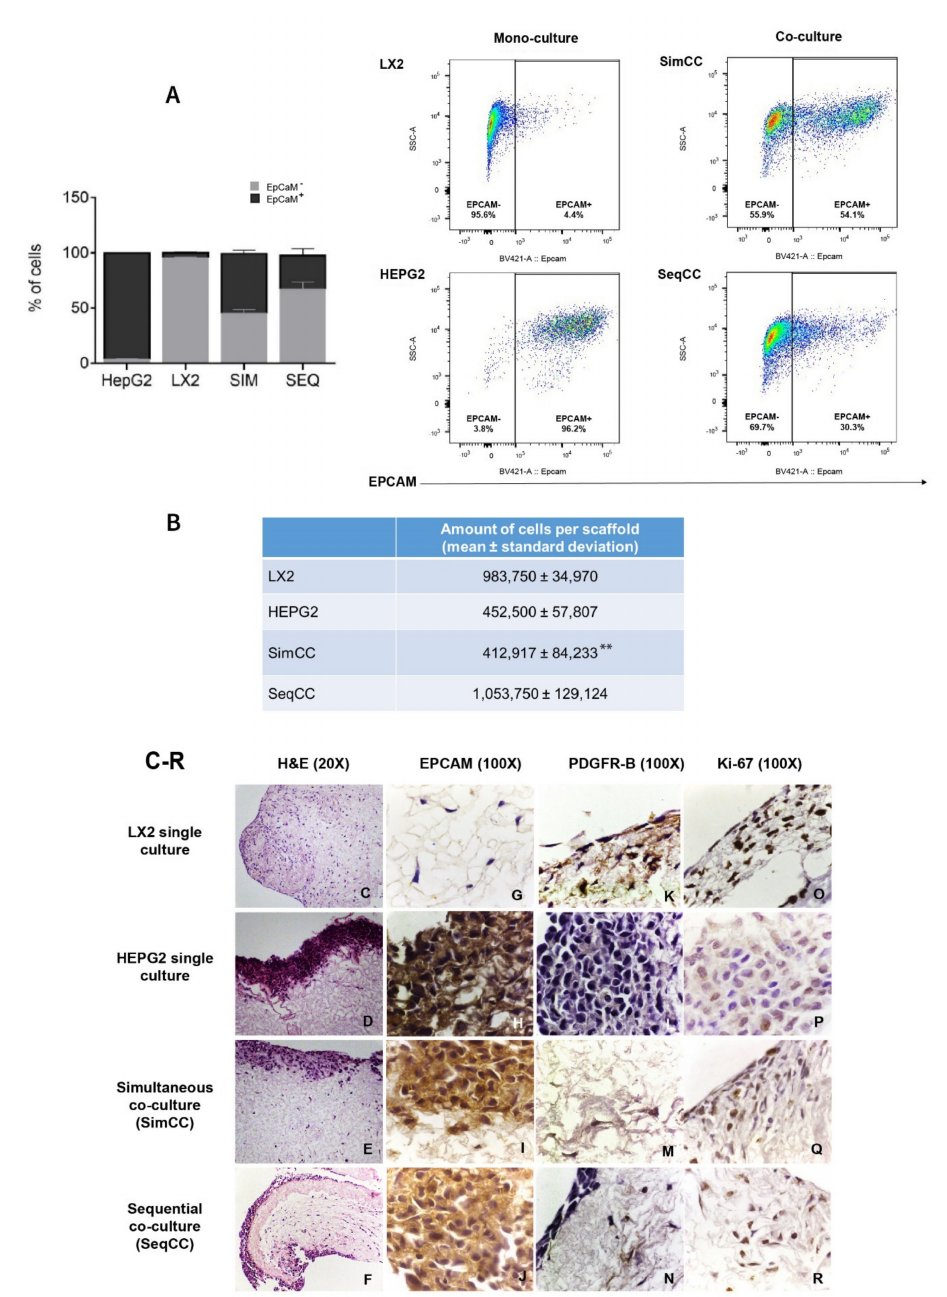
Figure 1. Localization and fluorescence-activated cell sorting (FACS) analysis of LX2 and HepG2 cells in single and co- cultures in 3D liver scaffolds. ( A ) Percentage of LX2 and HepG2 cells engrafted in healthy scaffolds in single cultures of LX2 or HepG2 cells, and co-cultures SimCC and SeqCC as determined by Flow cytometry analysis using EPCAM antibody. ( B ) Quantification of engrafted cells in single-cell cultures of LX2, HepG2, and co-cultures SimCC and SeqCC in healthy 3D liver scaffolds (** p ≤ 0.01 SimCC compared to SeqCC). ( C – F ) Hematoxylin and Eosin staining of LX2 and HepG2 repopulating 3D ECM healthy liver scaffolds showed LX2 cells diffusely spread inside the scaffold, while HepG2 cells engrafted at the periphery of the 3D scaffold (20X magnification). ( G – J ) Distribution of each cell type in single cultures, simultaneous co-culture (SimCC), and sequential co-culture (SeqCC) confirmed by epithelial cell marker EPCAM and ( K – N ) LX2 cell marker PDGFR- β immunohistochemistry (100 × magnification). ( O – R ) Cell proliferation was detected by performing Ki-67 immunohistochemistry (100 ×